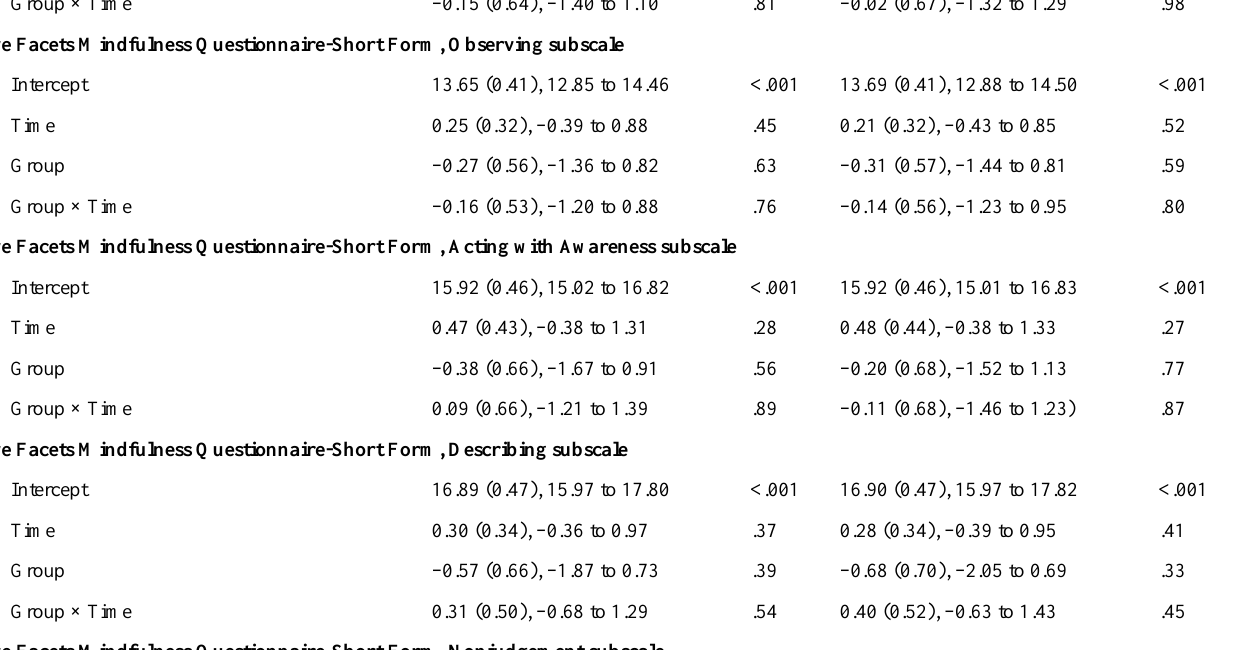
P valuePer protocol P valueIntention to